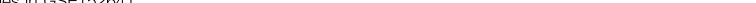
TABLE 9 | List of differentially expressed genes in GSE152641. Upregulated in